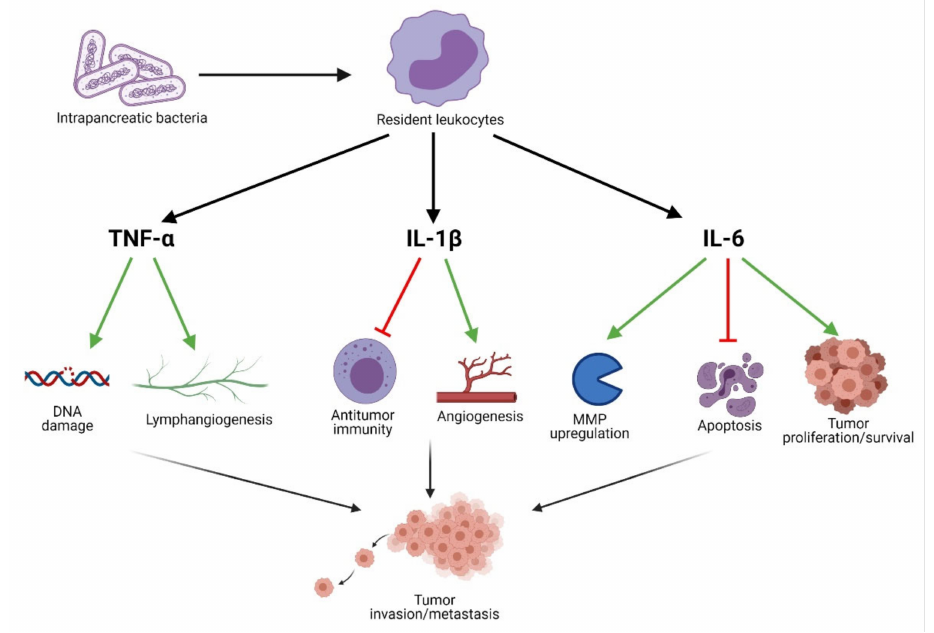
Figure 3. Inflammatory mediators contributing to pancreatic